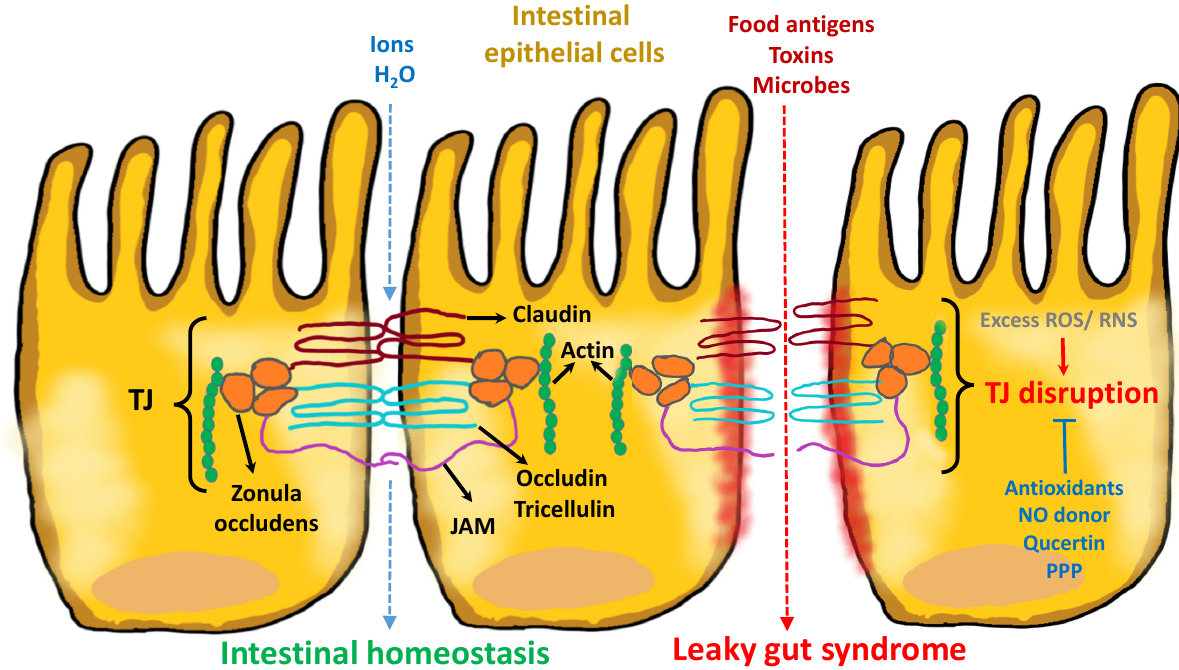
Figure 1. Schematic diagram showing the assembly of tight junctions (TJ) and the factors affecting TJ integrity. Intestinal homeostasis is maintained by an intact TJ, which is organized by occludin, claudin, JAM, and Tricellulin as well as zonula occludens in the intestinal epithelium. Redox imbalance due to toxic reactive species (ROS and RNS) disrupts the barrier function of the TJ, leading to enhanced permeability to incompletely digested food antigens, xenobiotics, and microbial products. Compromised barrier integrity eventually causes chronic inflammation in the intestine. In contrast, factors with antioxidant properties can ameliorate TJ damage and are potential therapeutic targets. Occludin, abundant at cell–cell contact points, is required for the organization and maintenance of the TJ. Occludin is phosphorylated during oxidative stress-induced TJ dis- ruption [27]. Phosphorylated occludin localizes in the membrane, while minimal